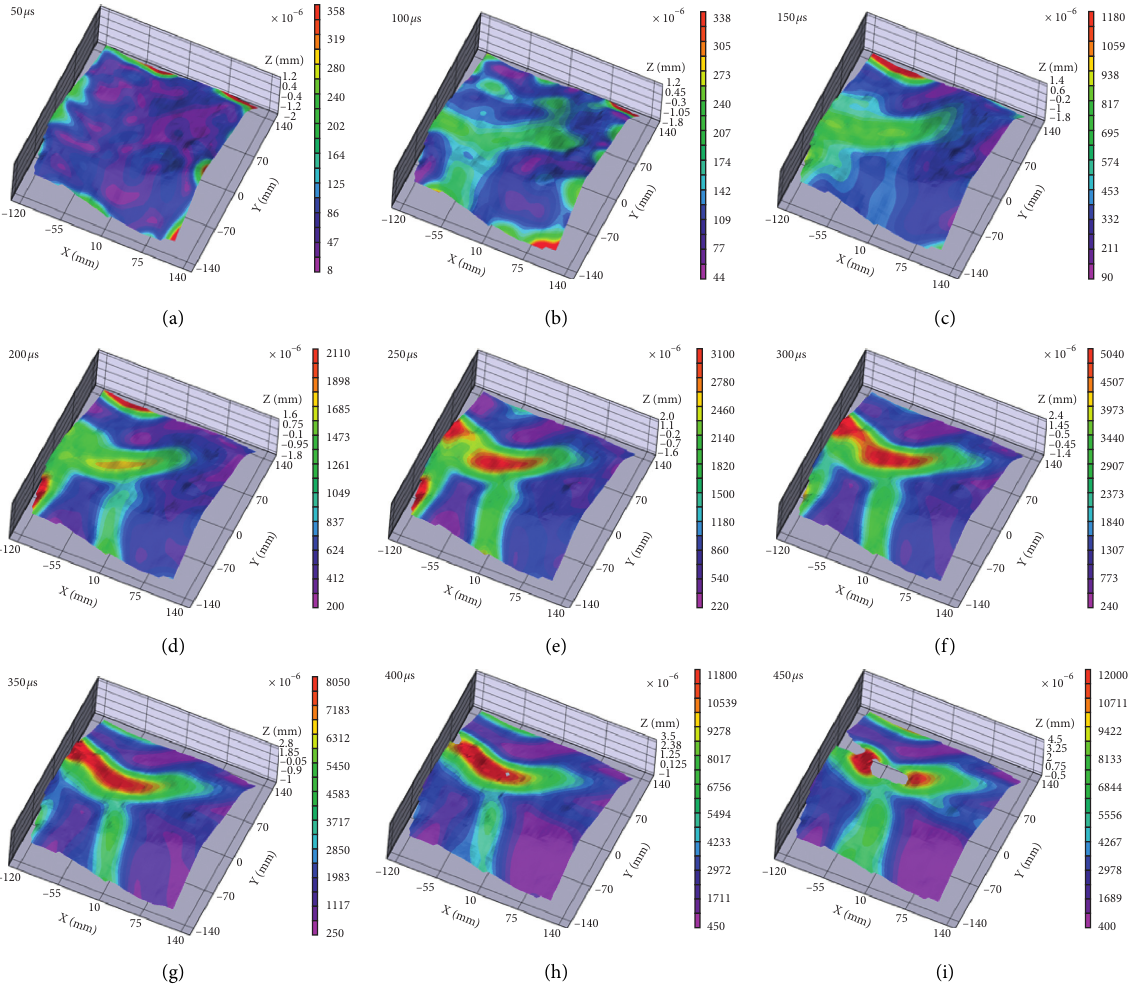
Figure 5: The evolution of von Mises strain for test 2. (a) 50 μ s. (b) 100 μ s. (c) 150 μ s. (d) 200 μ s. (e) 250 μ s. (f) 300 μ s. (g) 350 μ s. (h) 400 μ s. (i) 450 μ